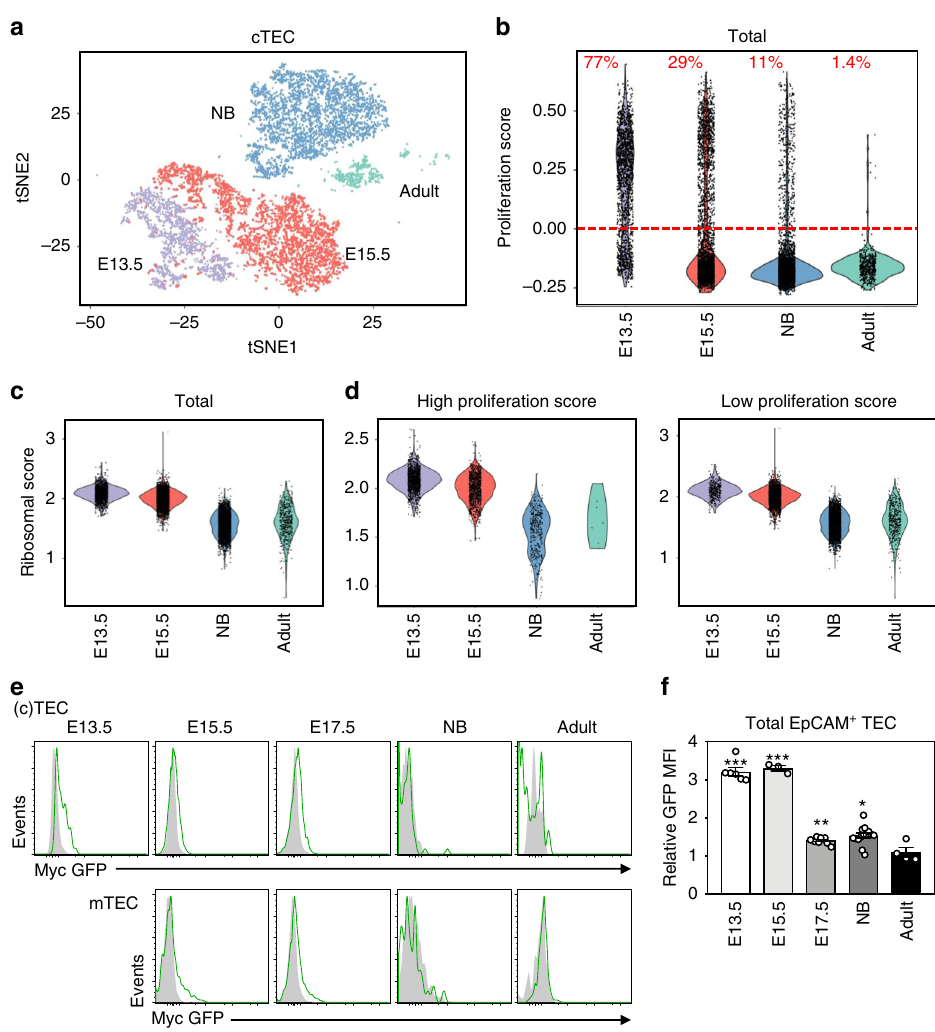
Fig. 3 A decline in Myc activity and protein levels in TEC during fetal development. Single-cell RNA-seq analysis of cell sorted total TEC (CD45 − EpCAM + ) from embryonic day 13.5 (E13.5, purple) and cTEC (CD45 − EpCAM + Ly51 + UEA − ) from embryonic day 15.5 (E15.5, pink), newborn (NB, blue) and adult (green) mice. a A t-SNE plot of TEC populations, colored and clustered by indicated ages; each dot is a cell. b A violin plot of the proliferation score applied to cells at each indicated timepoint. The red line separates cells with a high proliferation score above the line and a low proliferation score below the line; percentages of cells above the line are indicated in red. Violins plots of the ribosomal score applied to total cells ( c ), or cells with a high proliferation and low proliferation score ( d ) at indicated timepoints. e Myc-GFP levels displayed as histogram gated on CD45 - EpCAM + total TEC from E13.5, or cTEC (CD45 − EpCAM + Ly51 + UEA − ) (above) and mTEC (CD45 − EpCAM + Ly51 − UEA + ) (below) subsets from homozygote GFP-c-Myc knock-in mice at each indicated age, overlaid on litter mate WT GFP-c-Myc knock-in controls ( fi lled gray histograms). f Bar graph represents the relative Myc-GFP MFI against WT aged matched controls in total CD45 − EpCAM + total TEC at each indicated timepoint. Bar graphs show mean ± SEM for a minimum n = 3 mice per age. A two-tailed unpaired Student ’ s t test was performed to determine signi fi cance. * p < 0.05, ** p < 0.01, *** p < 0.001. The source data underlying ( f ) are provided as a Source Data fi